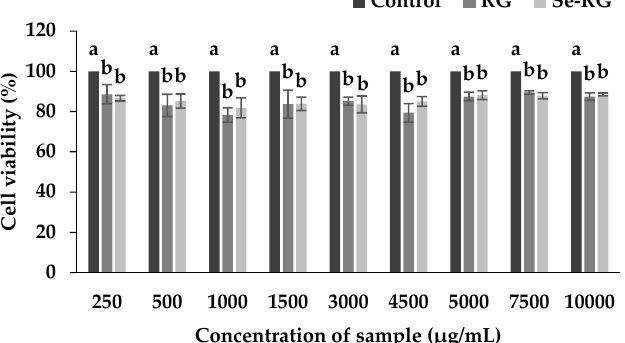
Figure 1. Effect of different concentrations of RG and Se-RG on the cell viability of HEK293 kidney cells. Data are means ± standard deviation (SD). Different letters indicated significant differences between treatment in the similar concentration of extracts ( p < 0.05) in Tukey’s significant differences test.